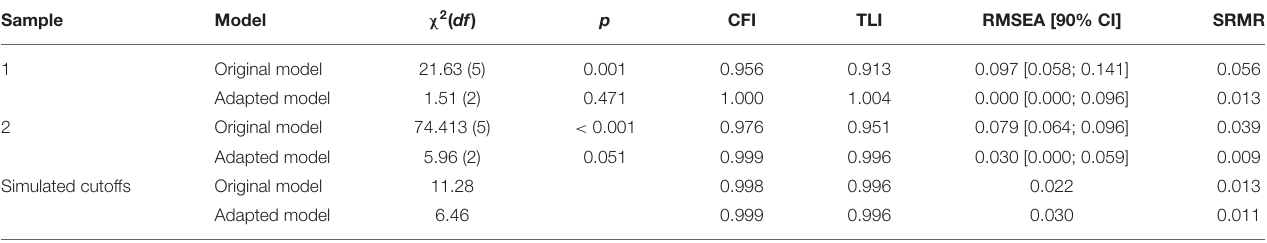
TABLE 3 | Confirmatory factor analysis results of the Self-Regulation of Eating Behavior Questionnaire (Samples 1 and 2).